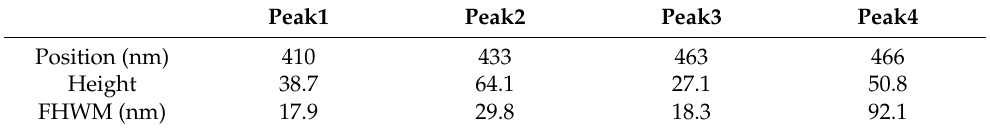
Table 3. Low-temperature fluorescence parameters of fitted peaks for Cs 3 Bi 2 Cl 9 QDs, results normalized. Peak1 Peak2 Peak3 Peak4